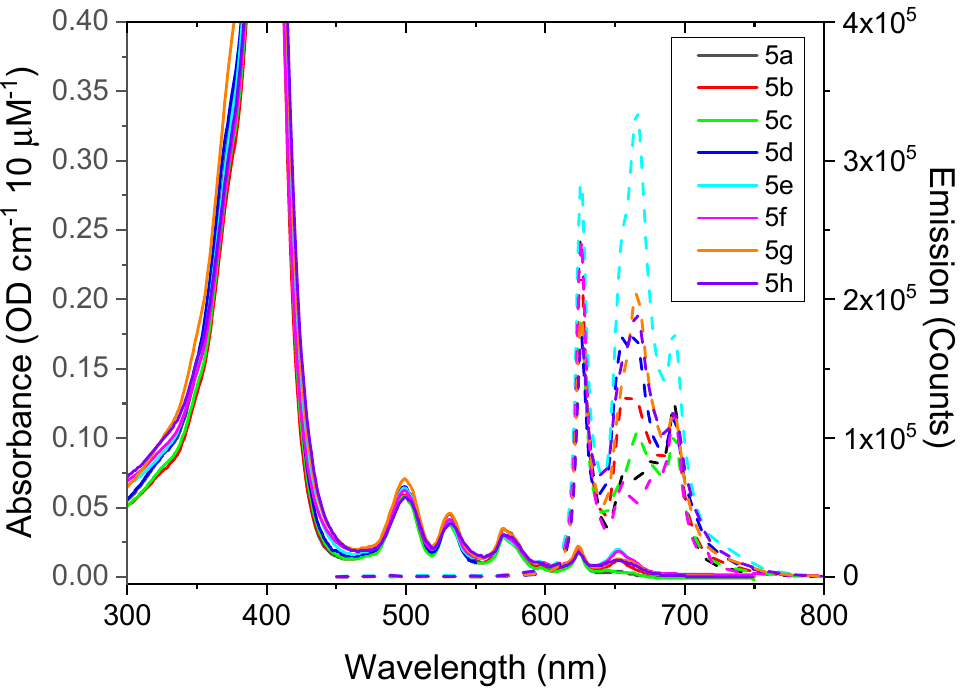
Figure 5. Absorbance (solid lines) and emission (dashed) spectra of compounds dissolved in H 2 O (10 µ M). Herein, the vertical scale of the absorbance is adjusted to focus on the Q-bands in the 500–650 nm range. The dashed curves are fluorescence emission spectra upon excitation at 425 nm.